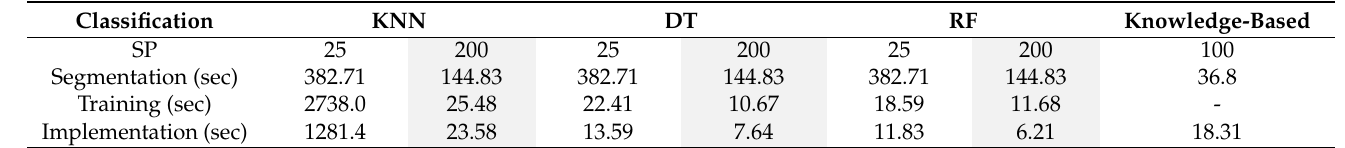
Figure 8. Example of classification results based on the RGB+DSM structure for different algorithms and SPs (Shape: 0.6) (green: non-affected, dark brown: scarp, light brown: depletion). The red polygon indicates the best classification result among the different setups. Table 3. Computational costs (in time) of different classifiers in relation to the